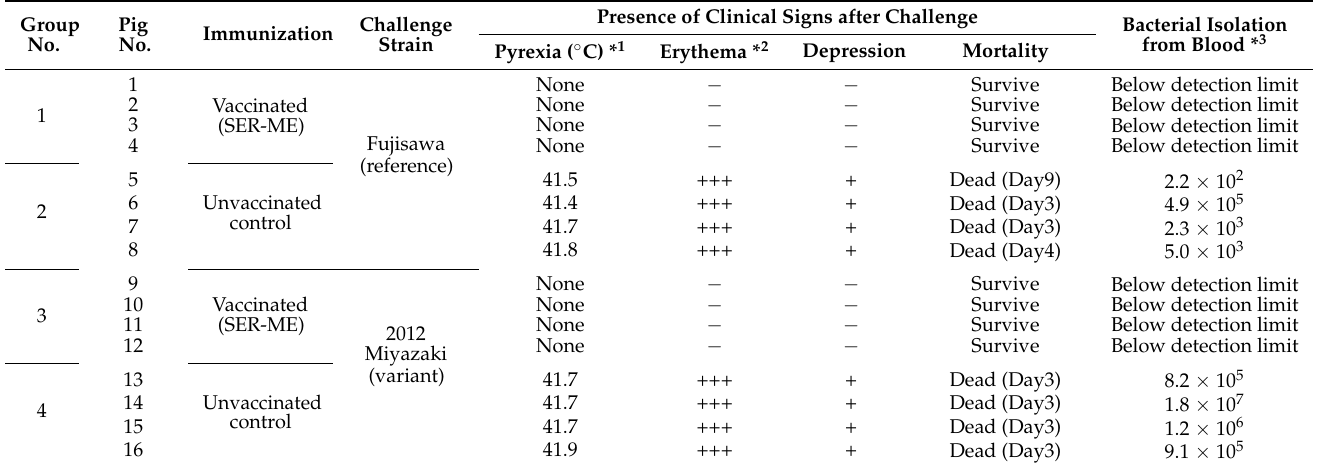
Table 2. Clinical responses of pigs challenged with E. rhusiopathiae